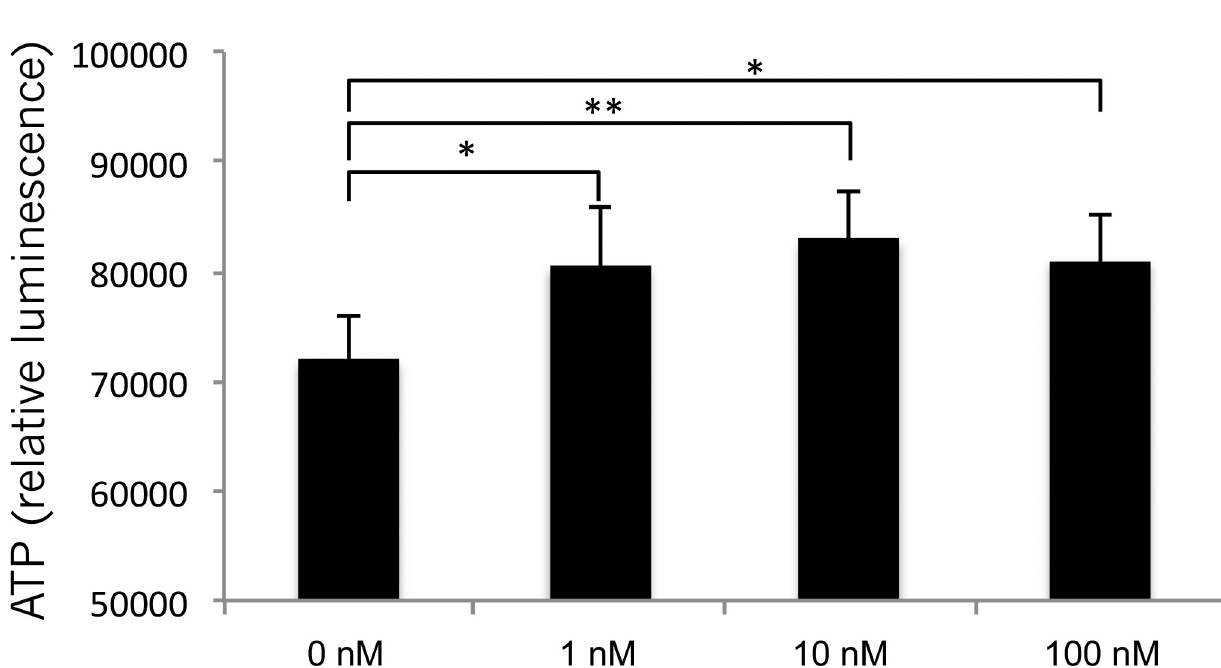
Fig 4. ATP production by HSG cells. ATP production by human salivary gland (HSG) cells was increased by incubation with ubiquinol in a concentration-dependent manner. Values are presented as the mean ± standard deviation (n = 4). Significant differences: � p < 0.05.